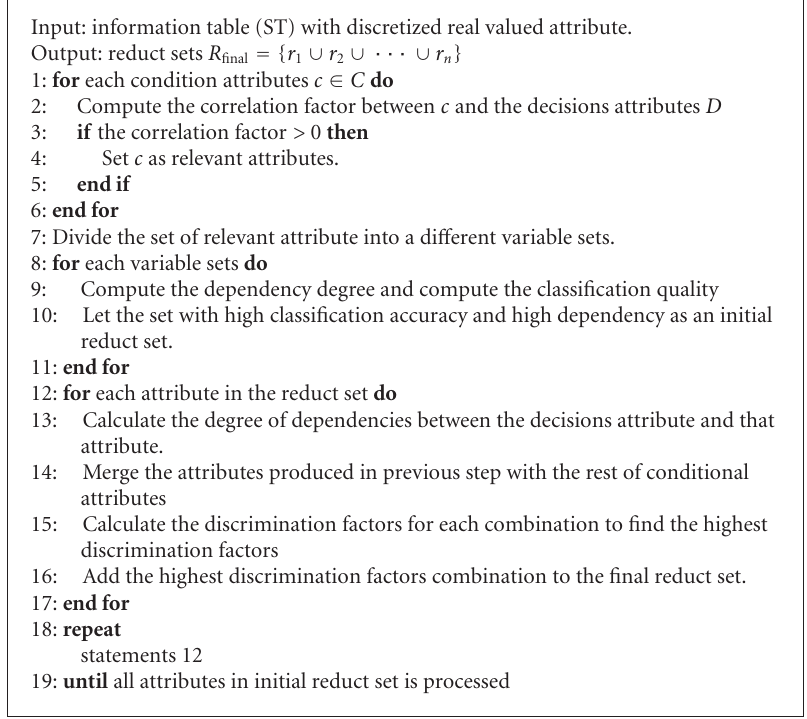
Algorithm 2: Reduct generation algorithm.